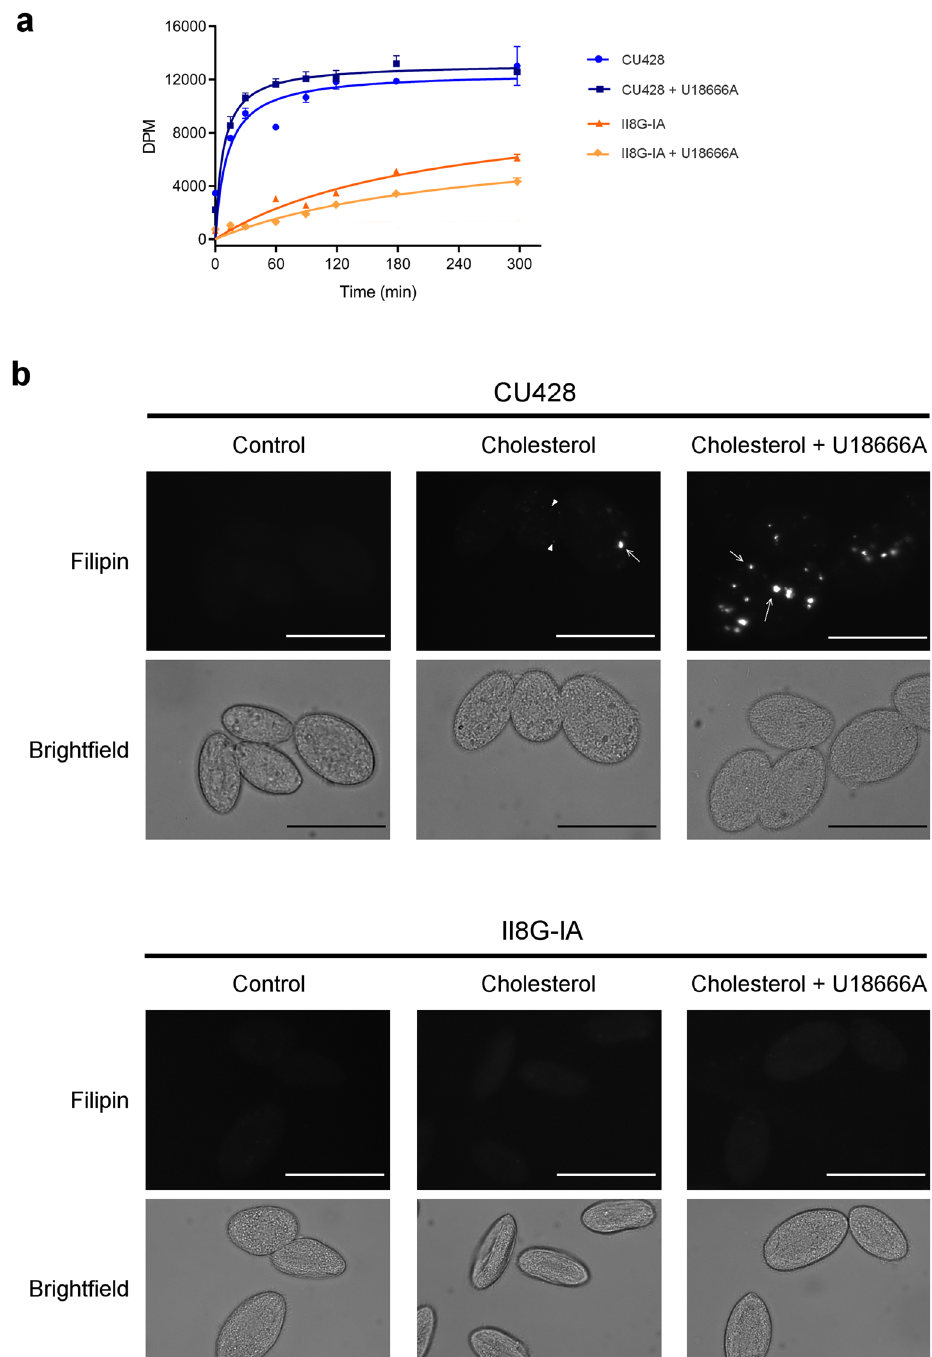
Figure 6. U18666A induces cholesterol accumulation in phagosome-like vesicles. ( a ) Kinetics of radiolabeled cholesterol incorporation in T. thermophila wild - type (CU428) and phagocytosis-deficient (II8G-IA) strains. The experiment was performed as described in legend of Fig. 1. U18666A (2 μM) was added 15 min before cholesterol. ( b ) Fluorescent microscopy. CU428 and II8G-IA cells were pretreated with 2 μM U18666A or vehicle for 15 min prior to the addition of 26 μM cholesterol. Untreated cells are designated as Control. After 1 h, cells were fixed, stained with Filipin and examined by fluorescence microscopy. Arrows indicate large, phagosome-like vesicles and arrowheads indicate selected small vesicles that were also observed in some cells. To improve visualization , some of the background fluorescence of CU428 cells was allowed, although II8G-IA cells required more contrast stretching as fluorescence levels were identical between treatments. Scale bar = 50 μm. Results shown are representative experiment repeated three times with similar